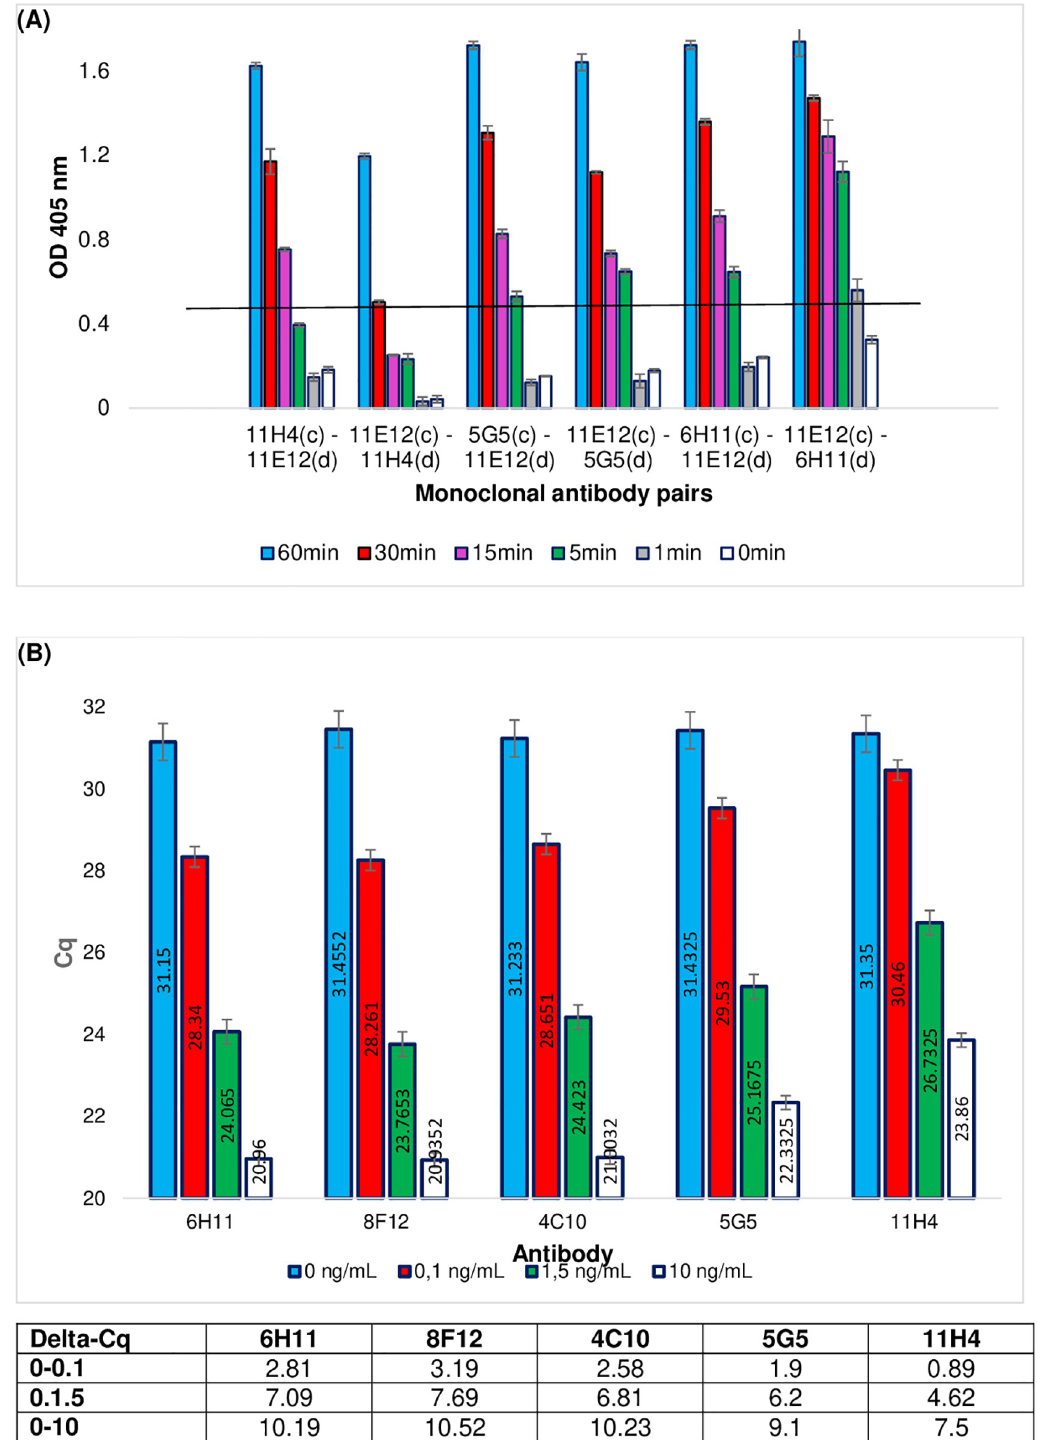
Fig 1. Selection of monoclonal antibody pair for PEA PCT. (A) OD at 405 nm for the different PCT antibody pairs tested in ELISA. For each pair, antibodies were tested either as capture antibody (c) or as detection antibody (d). Different incubation times were evaluated (60, 30, 15, 5, 1 and "0" minutes) for monoclonal antibodies binding to rPCT. The results correspond to the average of two duplicate experiments performed for each condition, after subtracting the blank (assay without rPCT). The black line corresponds to a positivity threshold representing 3 times the OD signal obtained on the blank. (B) PEA performed using